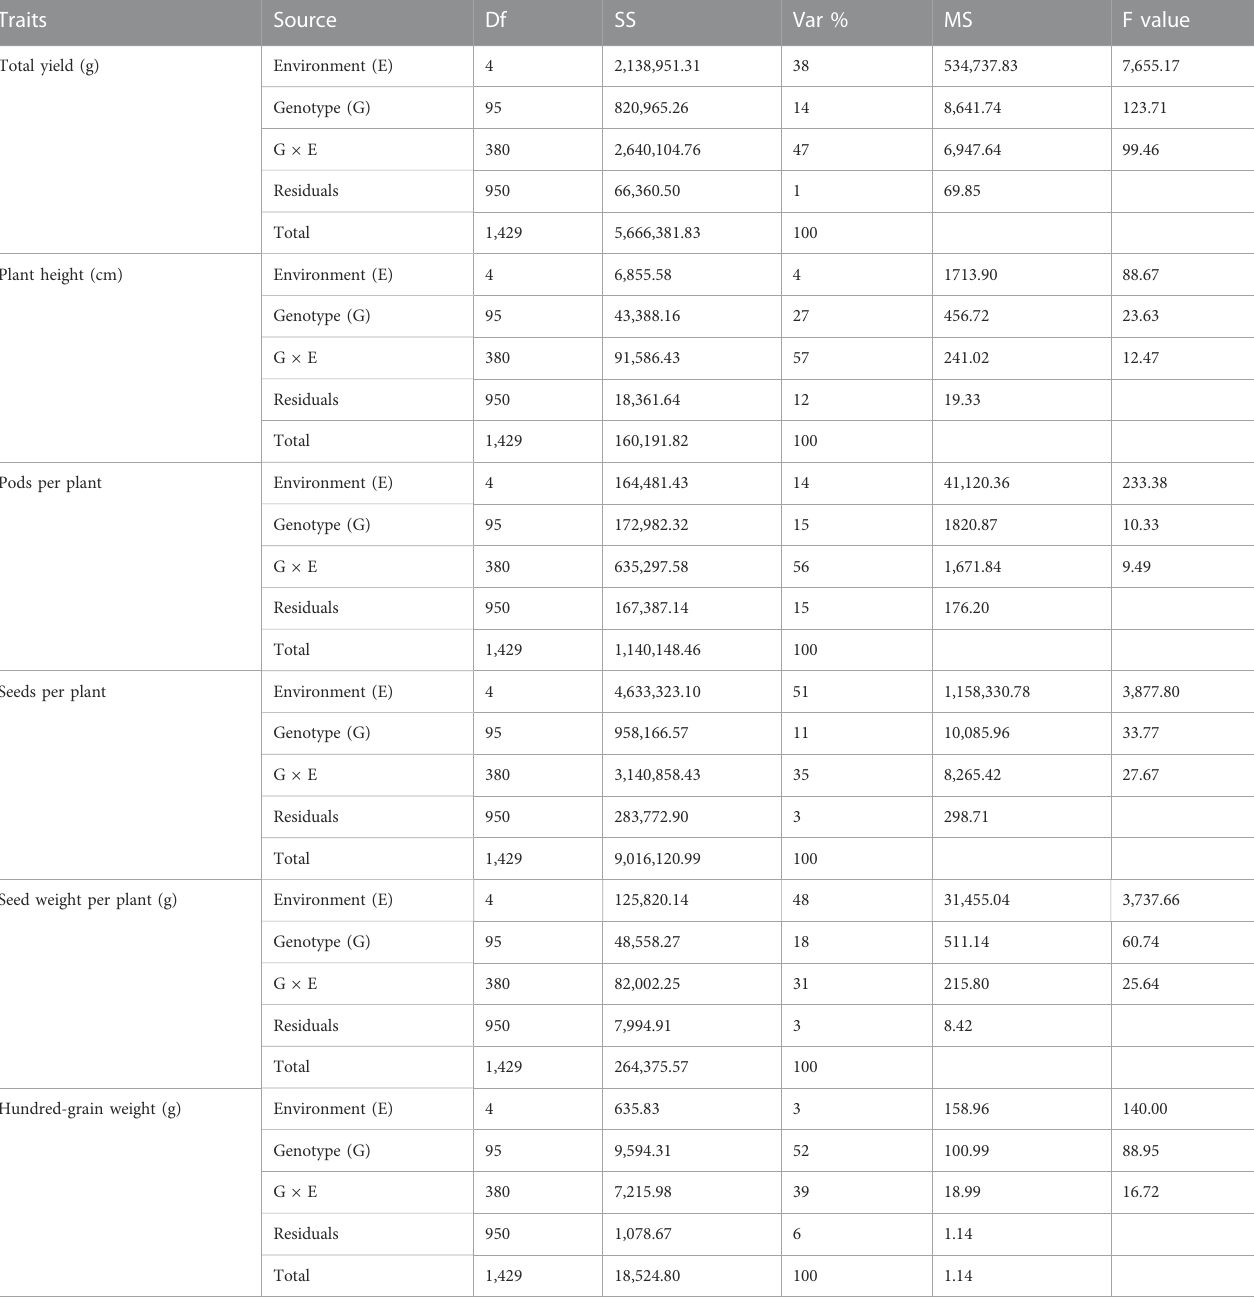
TABLE 3Analysis of variance (ANOVA) combined for total yield (TY), plant height (PH), pods per plant (PPP), seeds per plant (SDPP), seed weight per plant (SWPP), and hundred-grain weight (HGW). Traits Source Df SS Var %